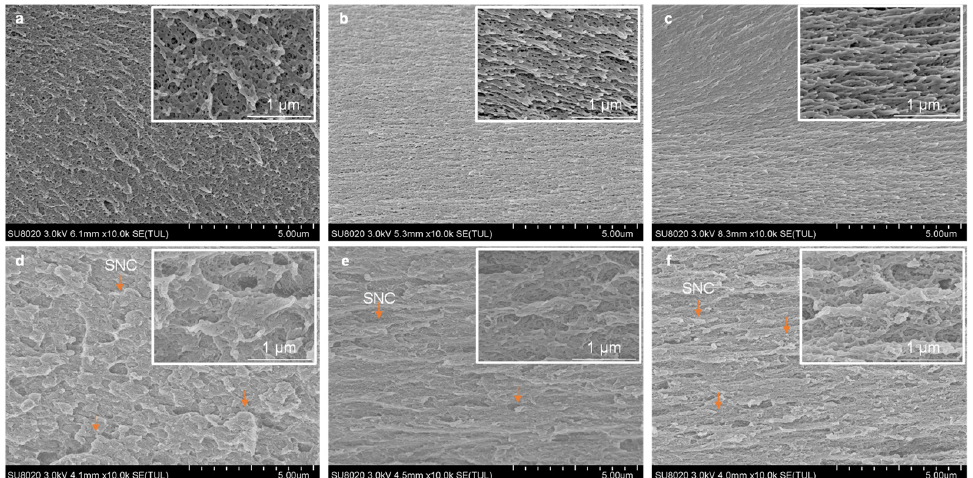
Figure 2. SEM image of cross-section for MC films and MC-SNC nanocomposite films: ( a ) M20; ( b ) A4C; ( c ) A4M; ( d ) M20-15% SNC; ( e ) A4C-15% SNC; ( f ) A4M-15% SNC.